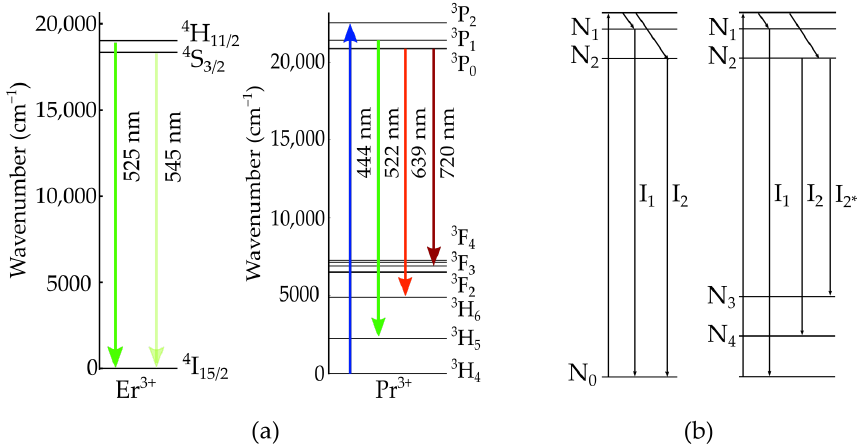
Figure 1. Energy levels of trivalent ions Er 3 + and Pr 3 + ions used in nanothermometry [6,7] with the optical transitions for excitation and emission in ( a ) and the corresponding 3-level and 4-level laser schemes in ( b